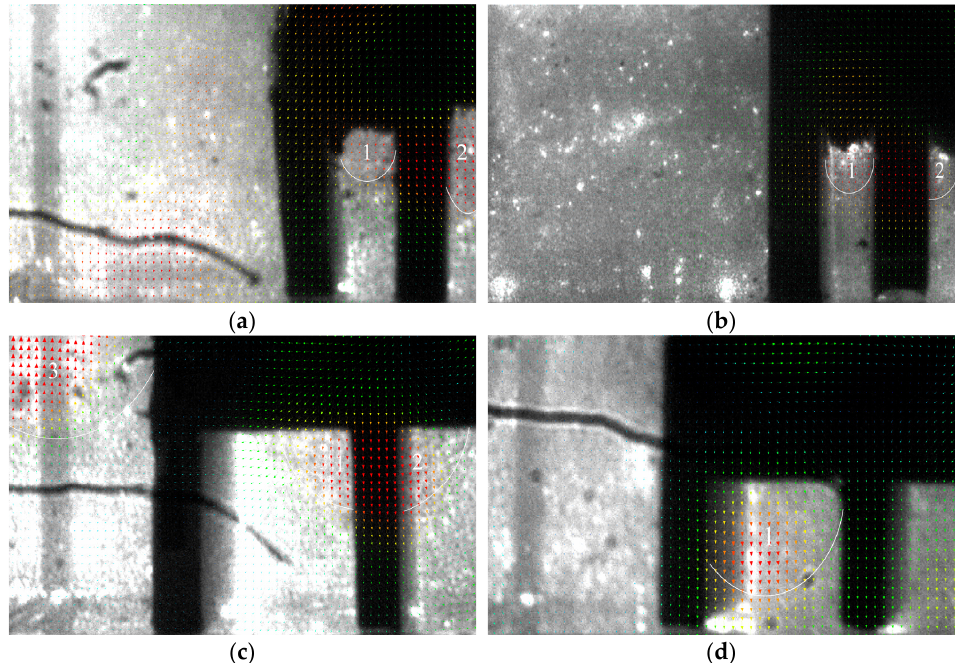
Figure 10. Vector diagram of ( a ) SN − 8 model, ( b ) SP − 8 model, ( c ) LN − 8 model, and ( d ) LP − 8 model.